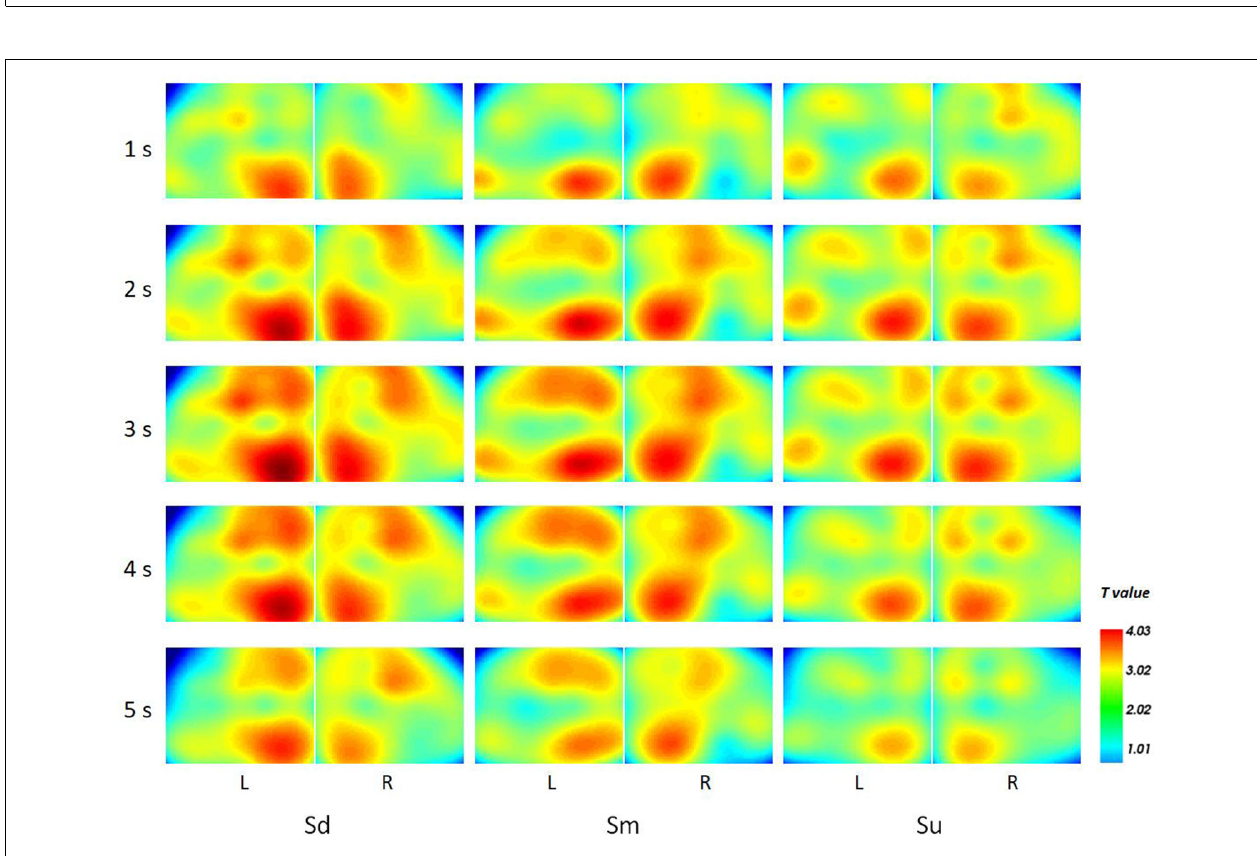
FIGURE 7 | The averaged HbO waveforms of all fNIRS channels for Sd, Sm and Su intentions for all participants. All channels have a positive amplitude at the 0 point because they were affected by the visual evoked potential induced by the − 500 ms cue stimulus. Channel marked with an asterisk indicates a statistically significant difference in the amplitude ( P < 0.05).